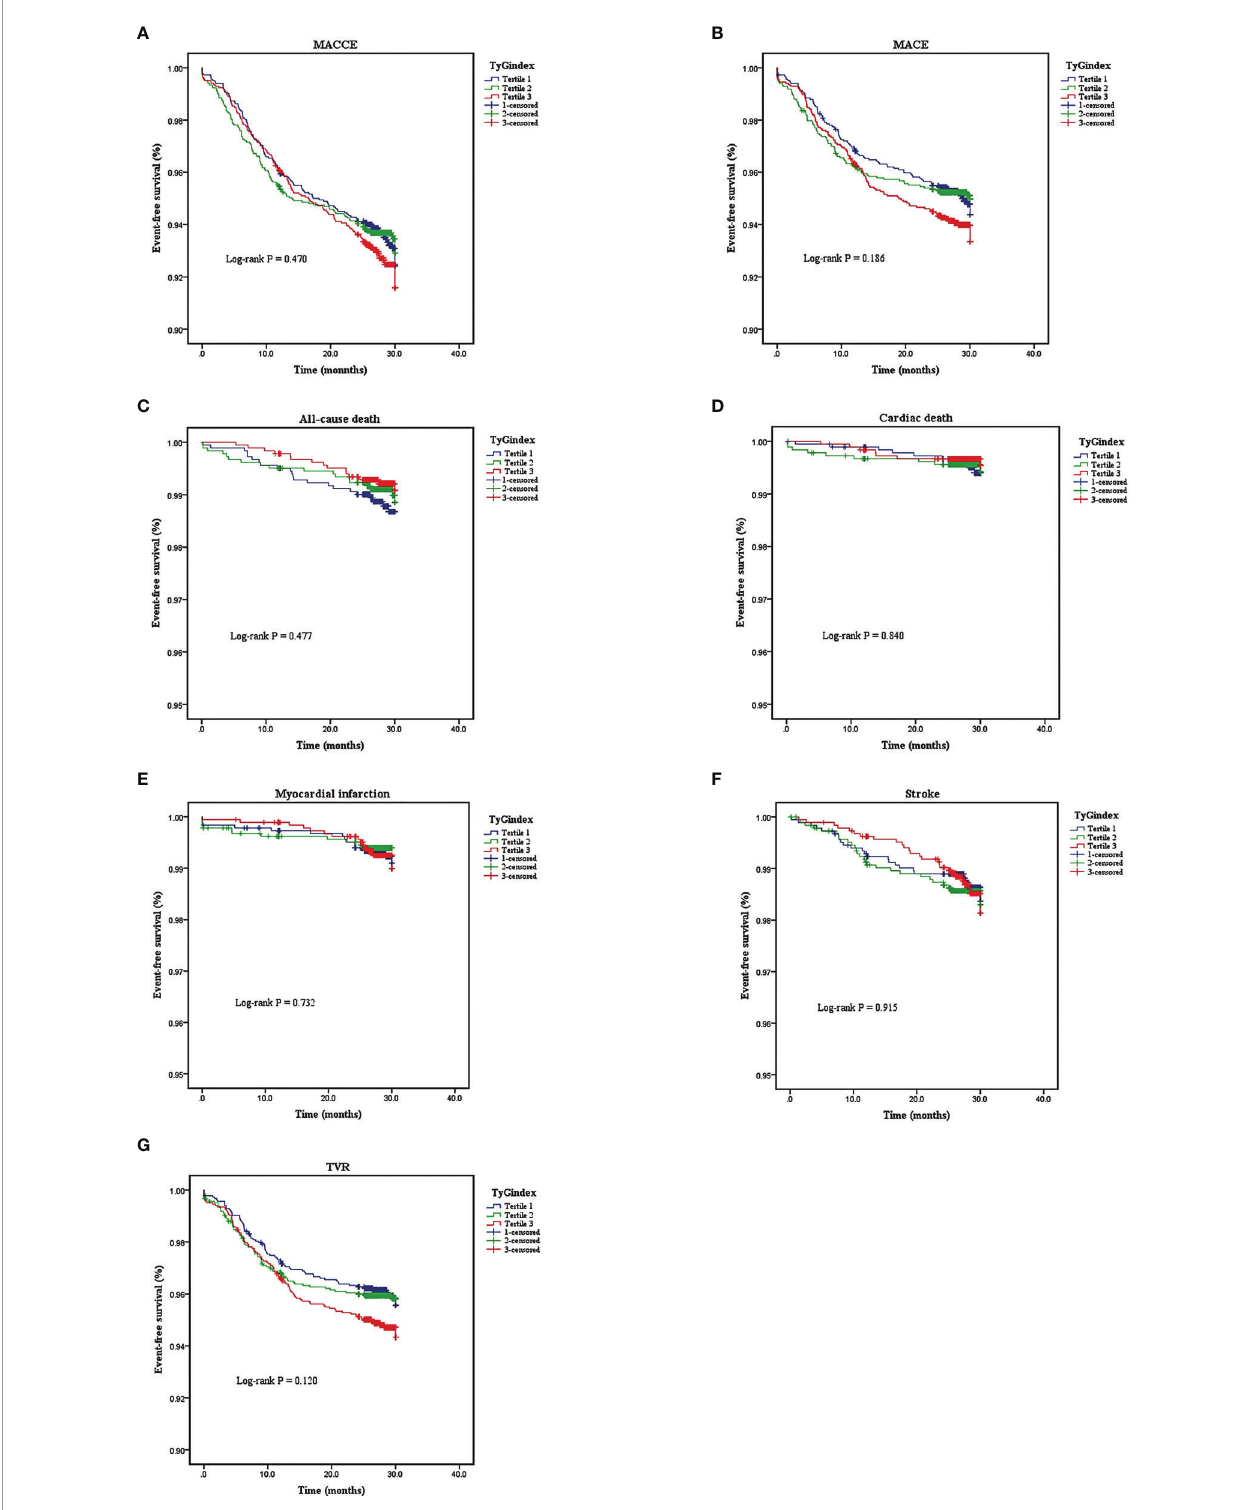
FIGURE 2 | Kaplan-Meier analyses for different endpoints among the three groups: (A) major adverse cardiovascular or cerebrovascular events (MACCE), (B) major advances cardiovascular events (MACE), (C) all-cause death, (D) cardiac death, (E) myocardial infarction, (F) stroke, (G) target vessel revascularization